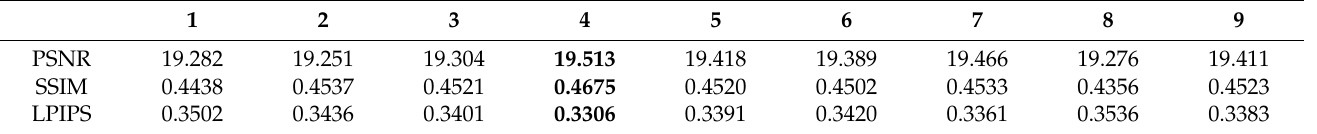
Table 2. Mean values of PSNR, SSIM and LPIPS for cross-validation. The best performance in bold.